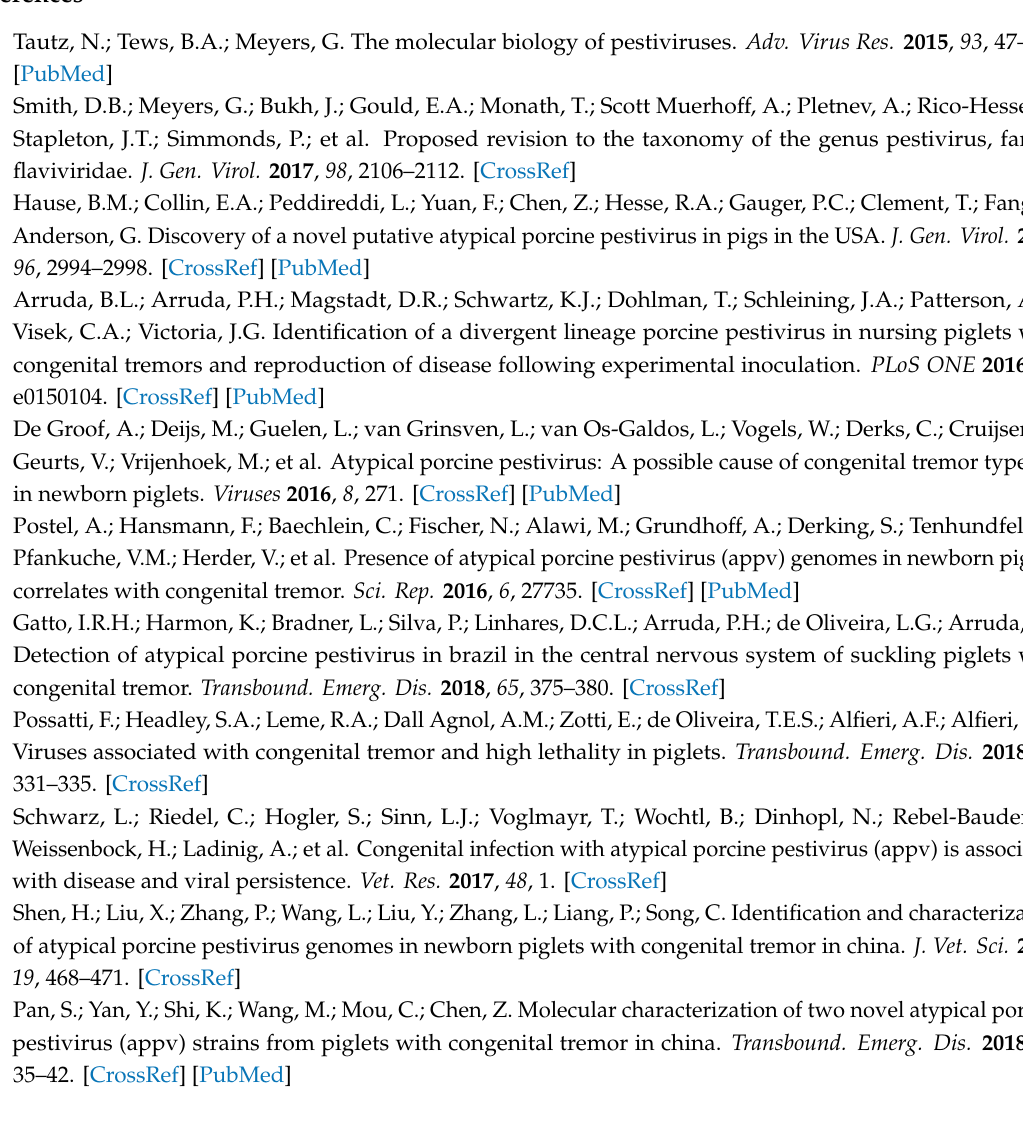
Figure S1: Course of APPV infection and antibody response in individual piglets, Figure S2: Development of a novel APPV Virus Neutralization Test